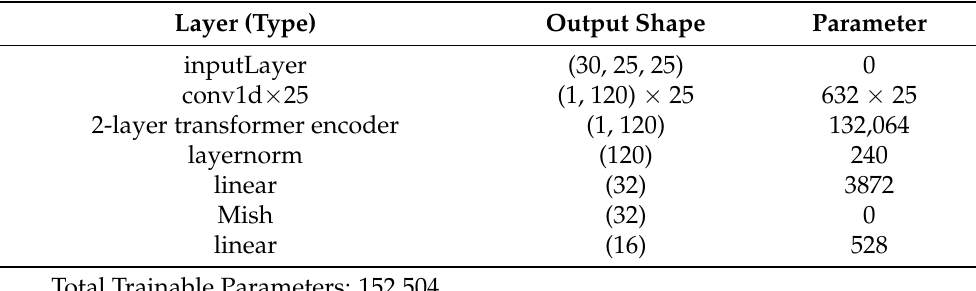
Table 5. Parameter summary of the proposed transformer model architecture over the Indian Pines data set.